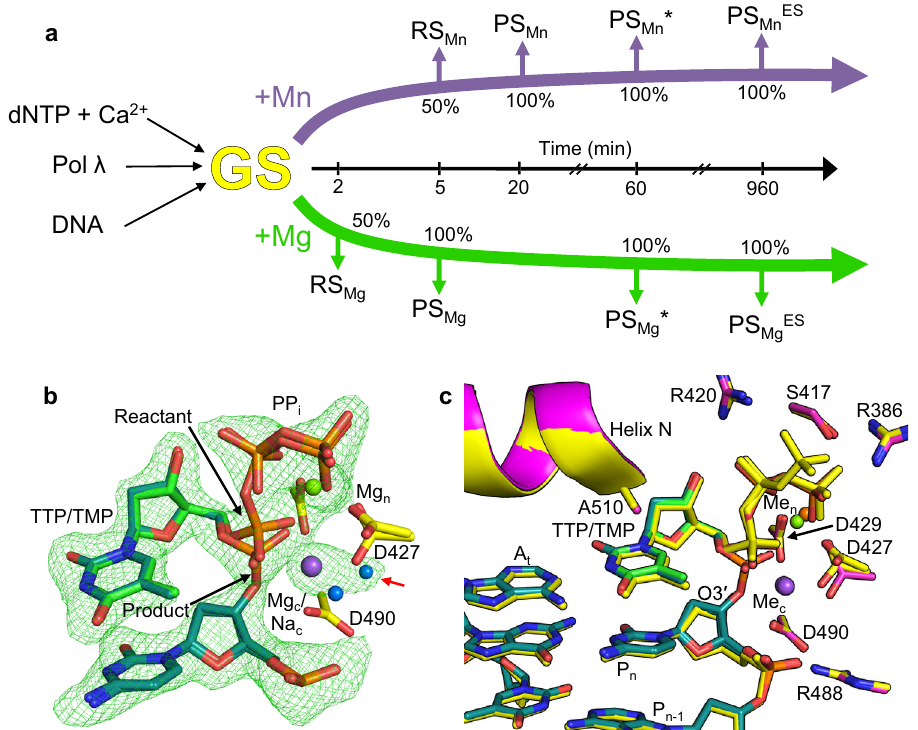
Fig. 2 Time-lapse crystallography and the matched Mg 2 + -reaction state ternary complex. a Time-lapse x-ray crystallography protocol. Ground state ternary complex crystals (GS, yellow) were grown by mixing pol λ , gapped DNA substrate, nucleotide (dNTP), CaCl 2 and precipitants. Ground state (GS) crystals were then soaked in a cryo-solution containing 50 mM Mg 2 + (green arrow) or 50 mM Mn 2 + (purple arrow) to initiate the reaction in the crystal. Crystals were frozen after increasing incubation times (central black arrow) and the structures of the intermediate complexes at increasing degrees of product formation (% incorporation) were determined. b Matched Mg 2 + -reaction state (RS Mg ) structure after a 2 min soak. Partial bond breakage in substrate (P α – P β of TTP) and bond formation in product (primer O3´ – P α of TTP) is visible, with inversion about P α and concurrent PP i formation. Rotation of Asp427 and presence of Mg 2 + in the nucleotide metal site (Mg n ) and Mg 2 + /Na + (Mg c /Na c ) in the catalytic metal site, is shown. Appearance of an alternate water molecule to coordinate the catalytic metal site (Mg c /Na c ) upon Asp427 rotation is indicated with a red arrow. Active site aspartates are shown in yellow stick representation, the incoming nucleotide in green, DNA in cyan. Mg 2 + and Na + are shown as green and purple spheres, respectively, water molecules are blue. The simulated annealing omit (F o -F c ) density (green mesh) shown is contoured at 3 σ , carve radius 2.0 Å. c Comparison of the Mg 2 + -reaction (RS Mg ) and ground state (Ca 2 + -GS) ternary complexes. The Ca 2 + -GS complex is shown in yellow, RS Mg is in magenta and are otherwise displayed as in ( b ). Ca 2 + is shown as an orange sphere. The primer terminal (P n ) and preceding (P n-1 ) nucleotides are indicated. The overlay was generated by superimposition of C α atoms of the respective palm domains (residues 386 – 494).